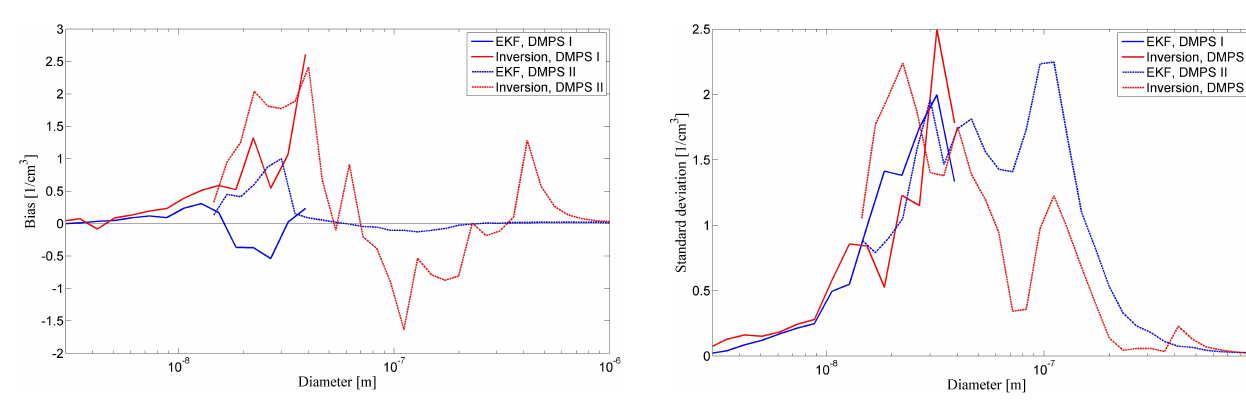
Fig. 3a. The bias of x EKF (blue) and x INV (red) as compared to the raw measurements from DMPS I (solid) and II (dashed) on 7 May 2007. The bias is on the y-axis [cm − 3 ] and particle diameter on the x-axis [m]. Note that the results are presented in the characteristic